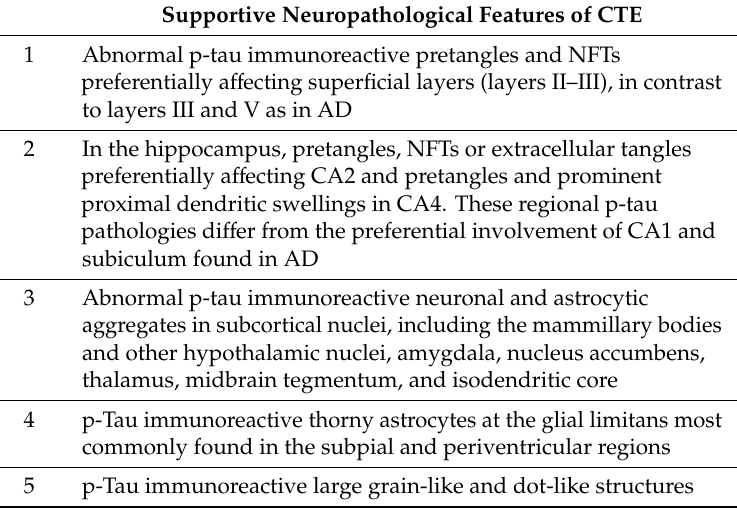
Table 4. Preliminary National Institute of Neurological Disorders and Stroke (NINDS) criteria for the pathological diagnosis of CTE [43]. Supportive Neuropathological Features of